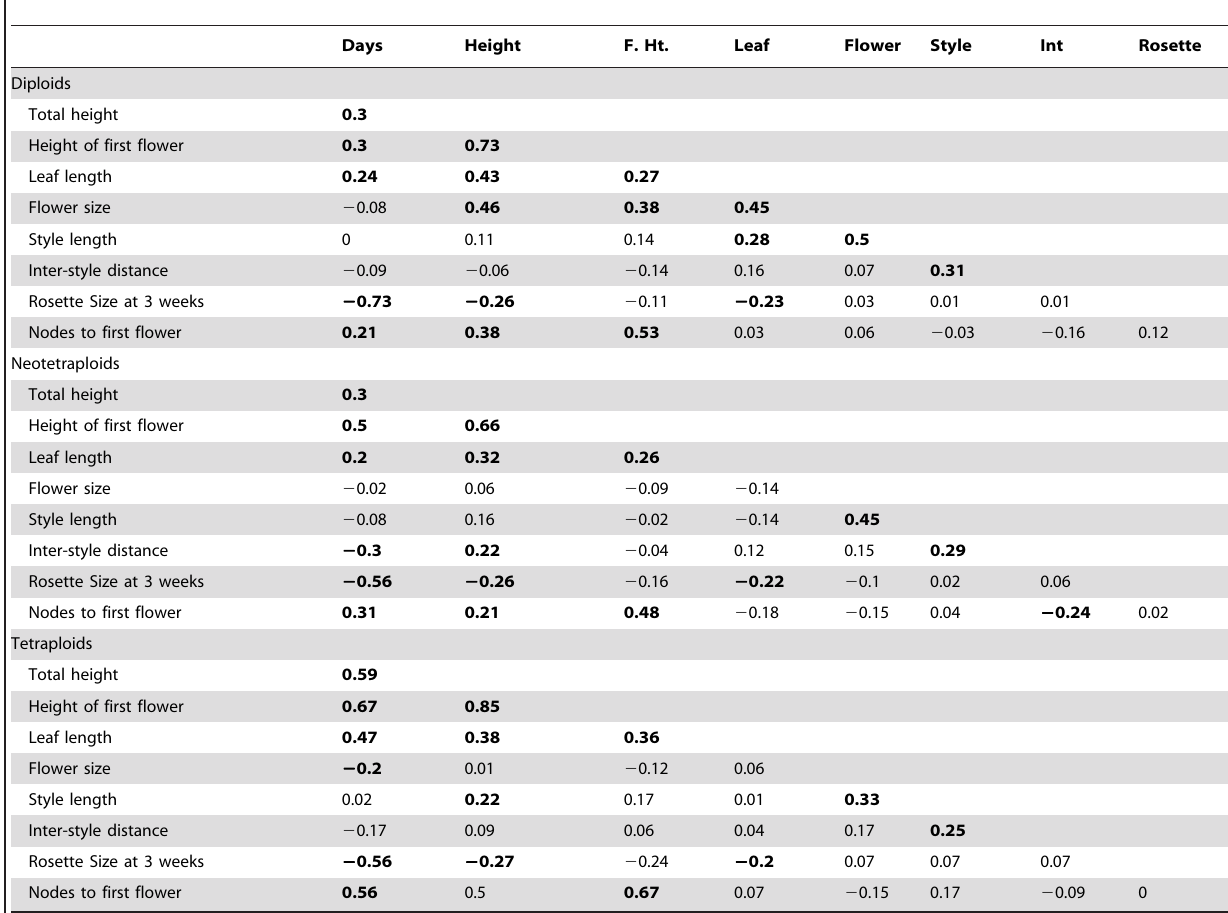
Table 5. Spearman rank correlations between characteristics in the base